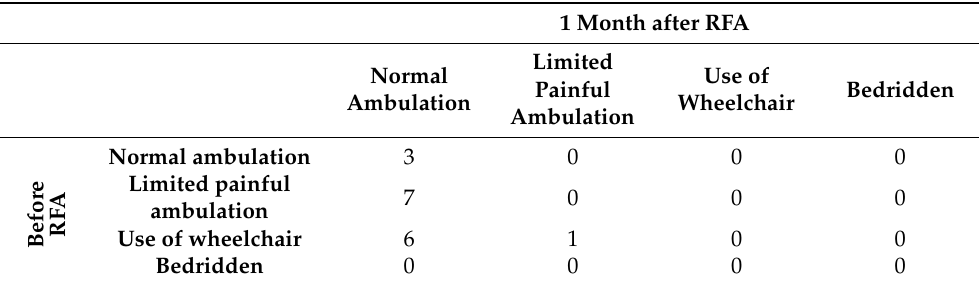
Figure 2. Successful treatment with tRFA and osteoplasty of painful breast cancer metastases of the right femur in a 61-year-old woman. Axial CT and Coronal-CT reconstruction showed a 52 mm lesion located in the head and neck of the right femur ( A , C ). Coronal-CT reconstruction showed the placements of the steerable bipolar radiofrequency device (tSTAR) (arrow). A second cannula is placed through the greater trochanter to extend osteoplasty (arrowhead) ( B ). Axial and Coronal-CT reconstruction showed the result after osteoplasty with PMMA ( D , E ). Table 2. Between walking performance rated on the Functional Mobility Scale (FMS) and measures of walking capacity after the treatment. 1 Month after